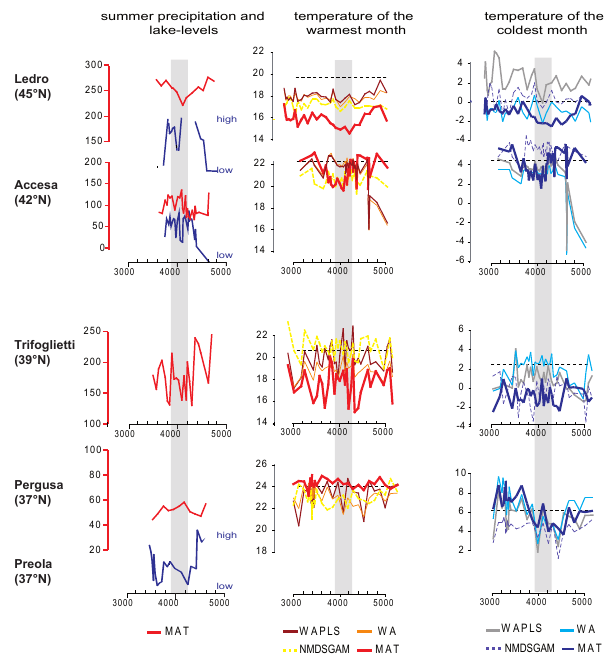
Fig. 8. Synthesis figure for the 4.2kyr event in Italy, and comparison with lake-level